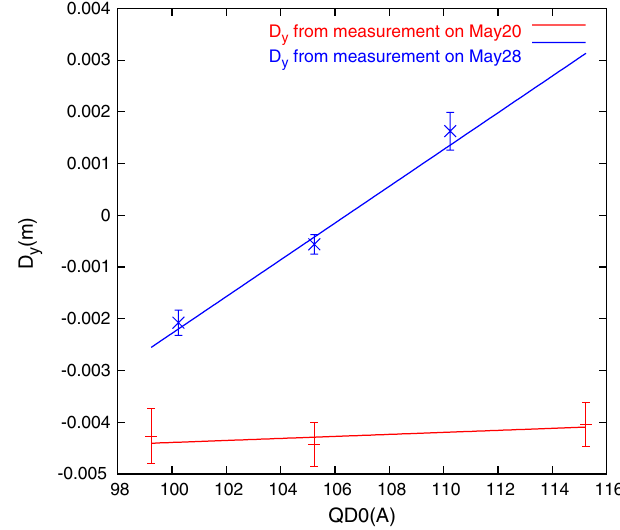
FIG. 4. Vertical dispersion measurements at post-IP wire scan-